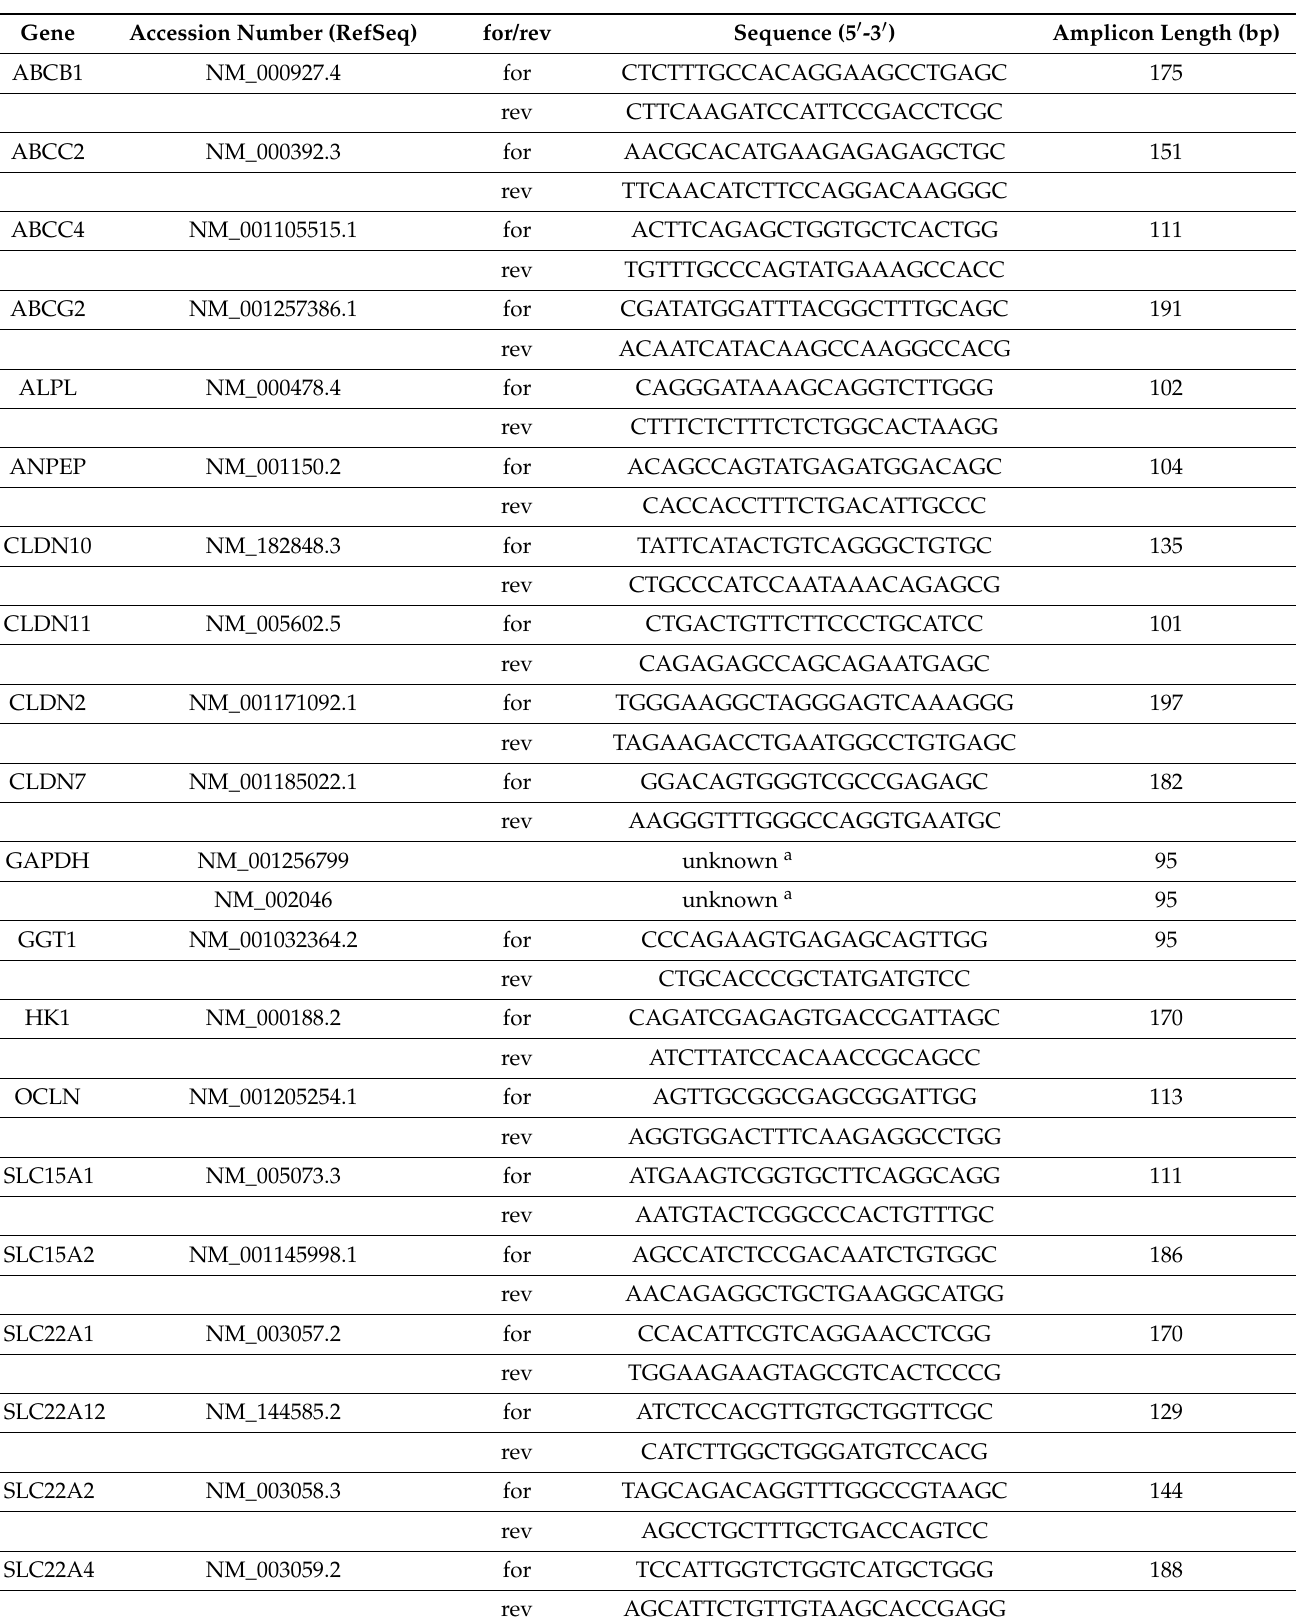
Table 4. List of primers used for qPCR (Homo